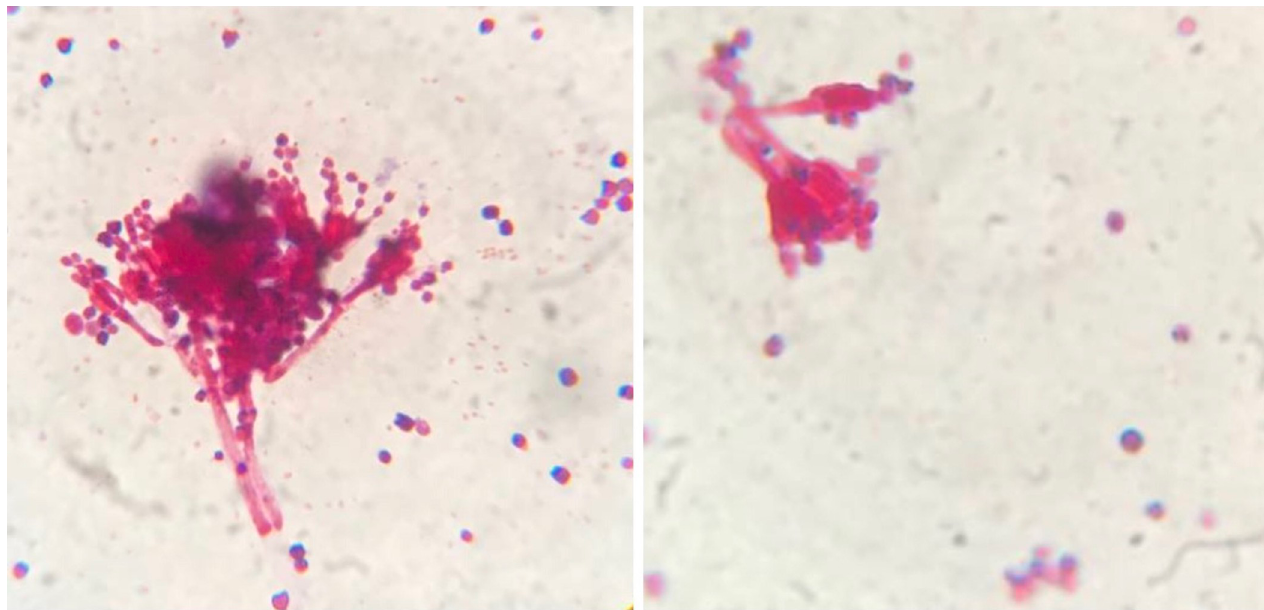
Fig 6. Micrographs of gram-stained smears of colonies in vaginal sample cultures of two mice in arm 5. The depicted micrographs were taken from gram- stained slides prepared with the colonies from mice’s vaginal sample cultures on SDA plates. C . albicans yeasts are seen undergoing filamentation in the depicted micrographs. Abbreviations: SDA, Sabouraud dextrose